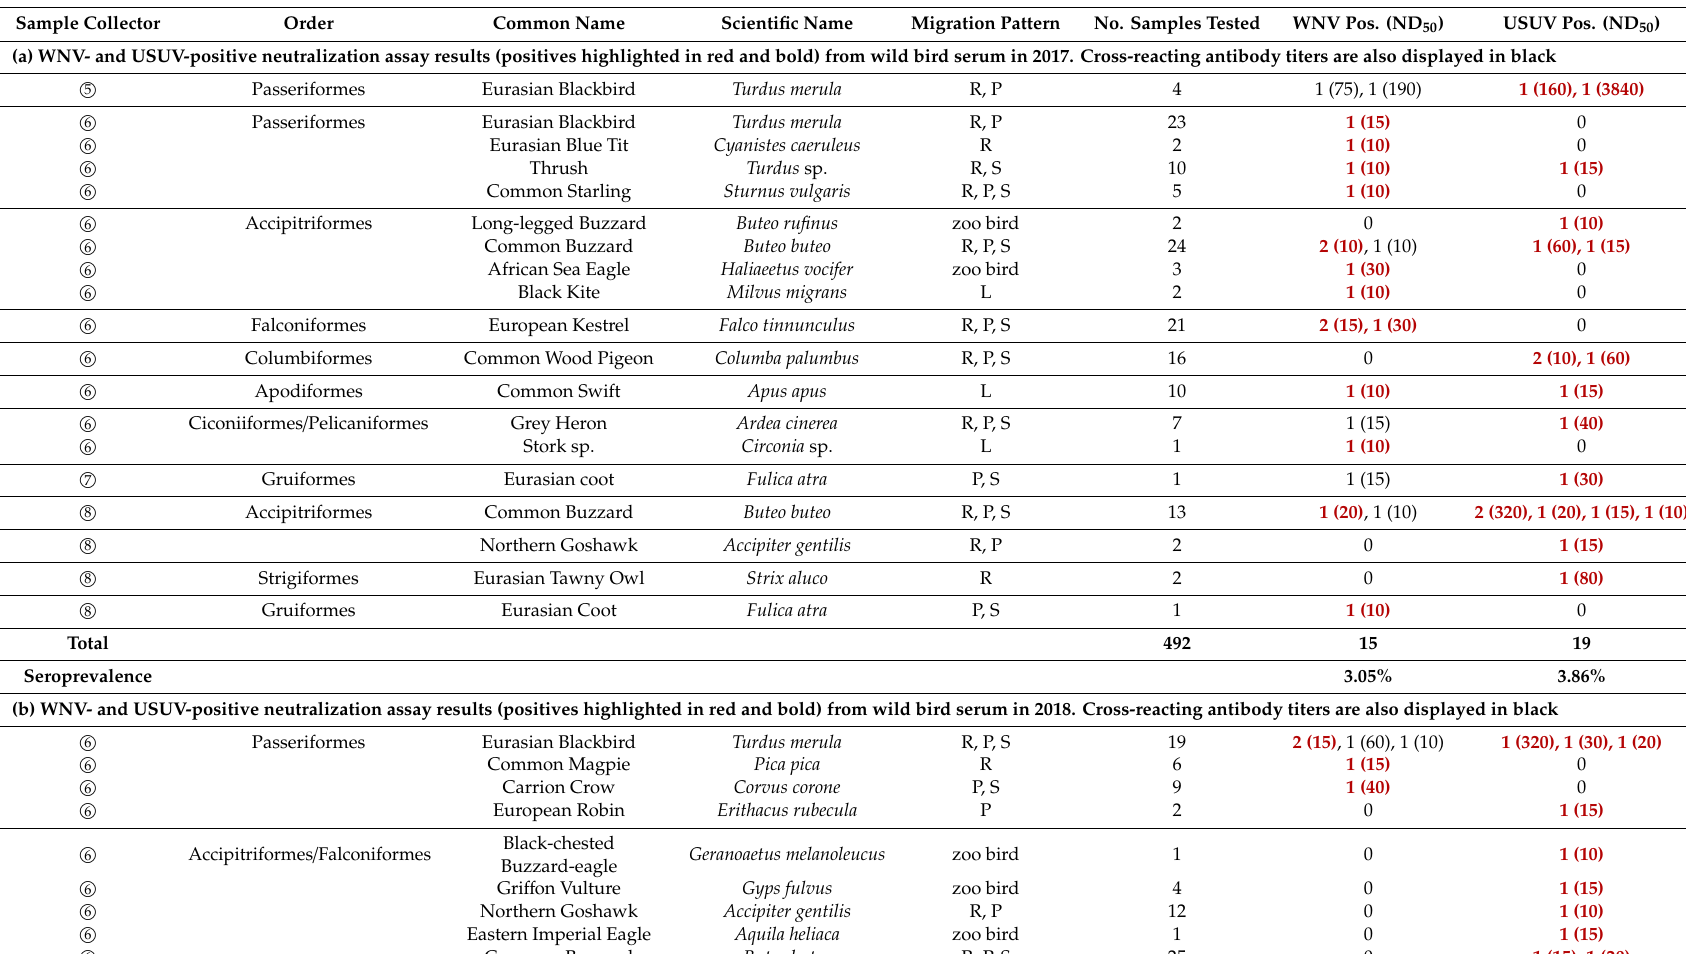
Table 6. WNV- and USUV-positive neutralization assay results from wild bird serum samples Region C—Central and Southern Germany. Sample